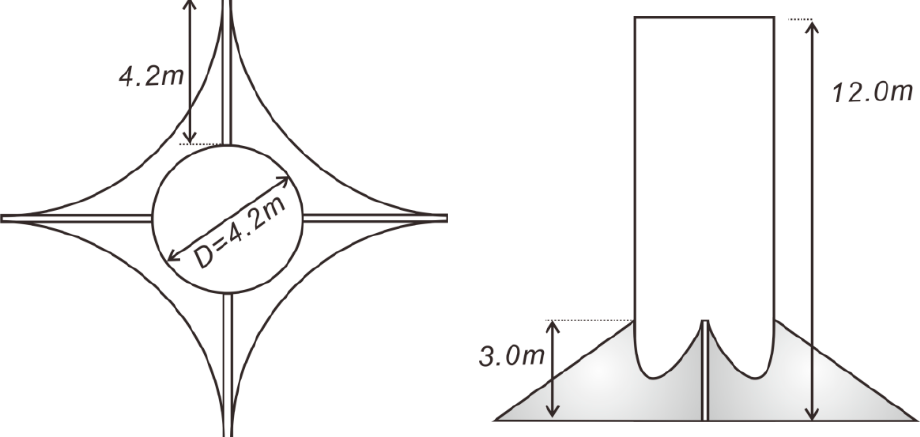
Figure 18. Dimensions of the Quattro-pod mono-pile.